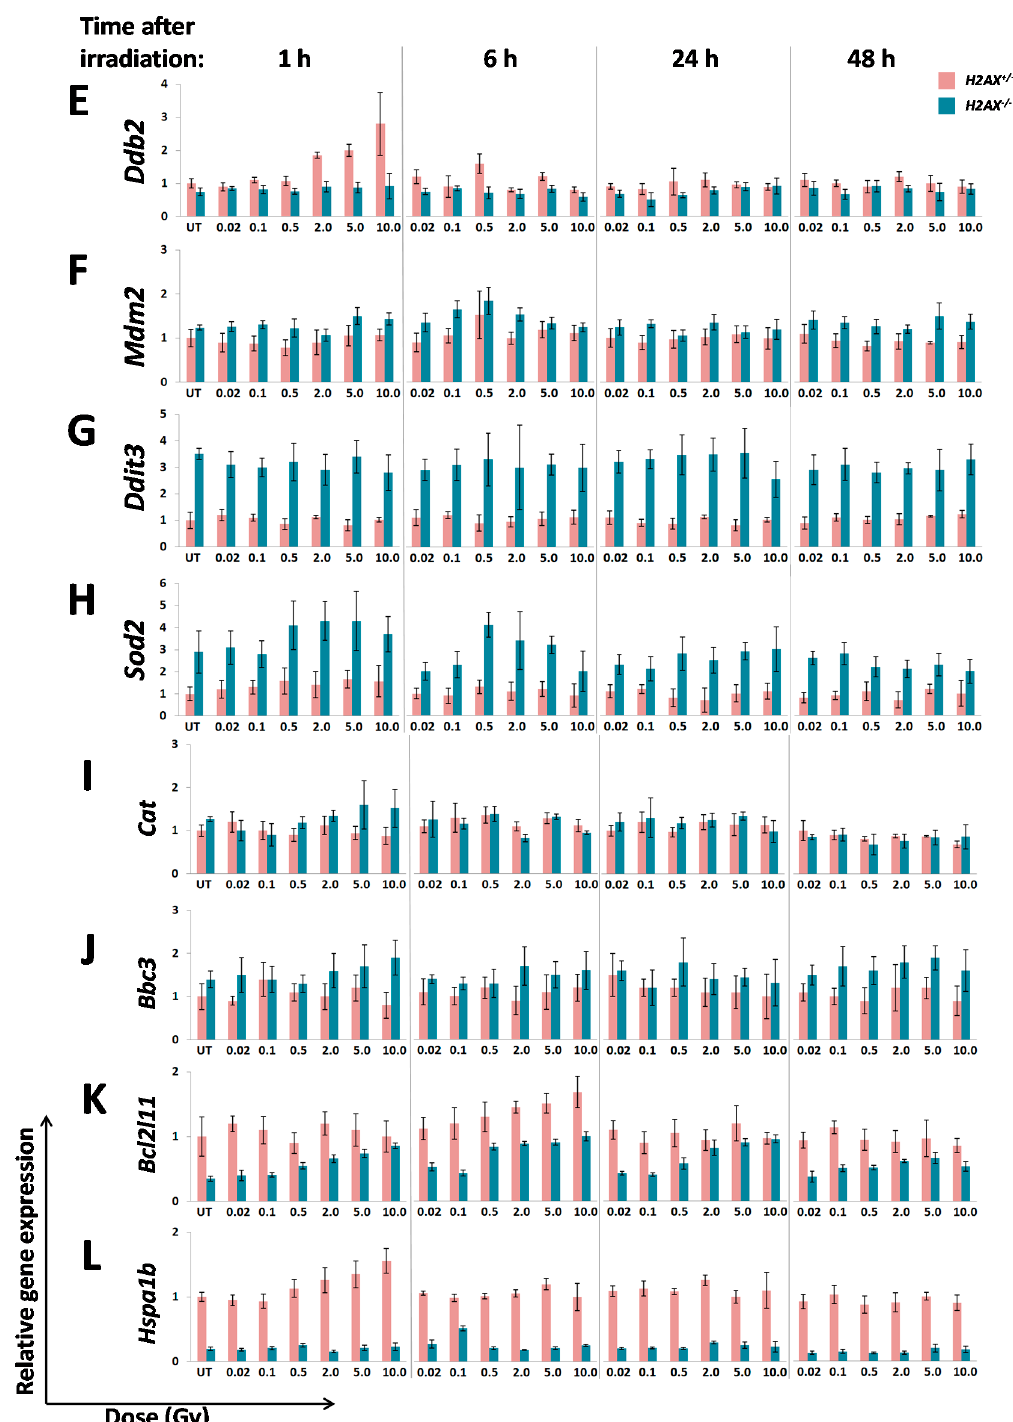
Figure 3. Radiation dose responses and time courses of the expression of genes regulated by FoxO3a in H2AX + / + and H2AX − / − MEFs. Cells were irradiated with the indicated doses of γ -radiation and at 1, 6, 24 and 48 h RNA was extracted and the expression of Foxo3a ( A ); Cdkn1a ( B ); Gadd45 α ( C ); Ddb1 ( D ); Ddb2 ( E ); Mdm2 ( F ); Ddit3 ( G ); Sod2 ( H ); Cat ( I ); Bbc3 ( J ); Bcl2l11 ( K ); and Hspa1b ( L ) were measured using RT-qPCR as described in Experimental Section. The expression values shown are relative to corresponding untreated controls and were calculated using the ∆ C t method as described in Figure 2. Data for each time-point had its own control, however, shown are only 1 h controls due to space limitation. Data represent the mean ± SD obtained from three independent experiments.